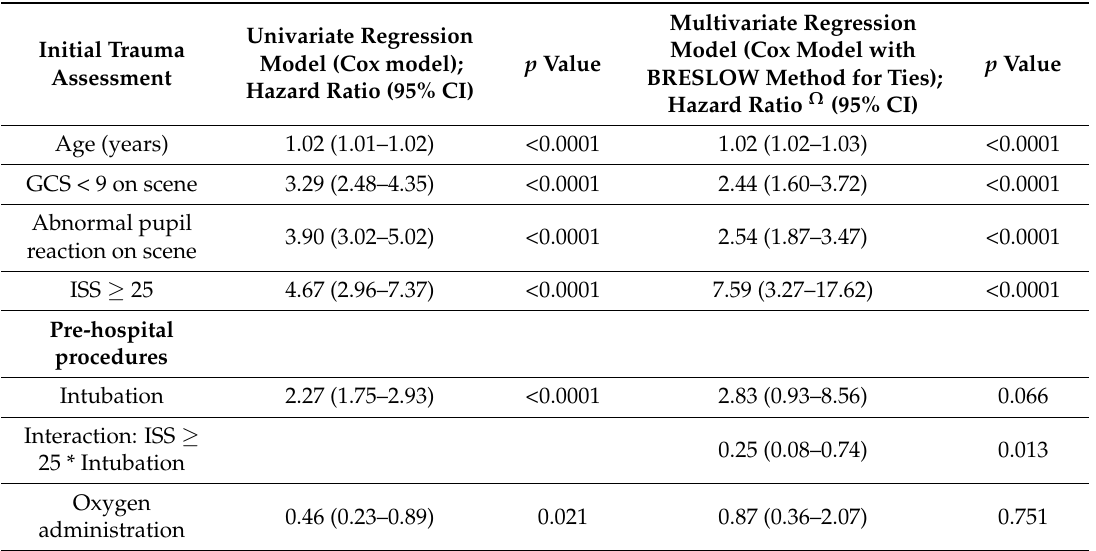
Table 5. Univariate and multivariate analyses of surviving and non-surviving patients with severe traumatic brain injury at 14 days including the interaction between severely injured patients and intubation (modification